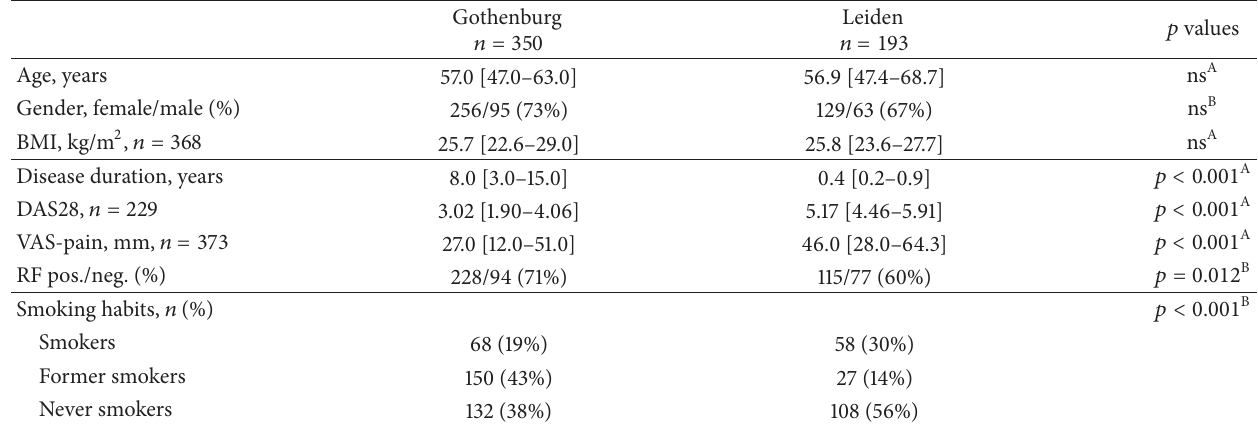
Table 1: Clinical and demographic characteristics of patients with rheumatoid arthritis in the Gothenburg (Sweden) and Leiden (The Netherlands) study